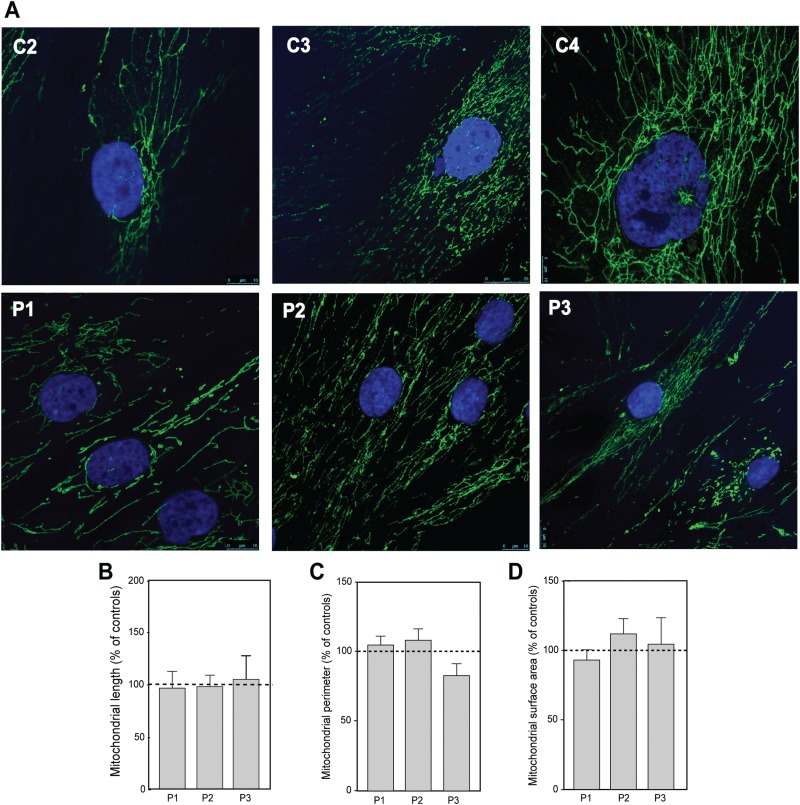
Morphology of mitochondria in CMT2AMFN2 patient fibroblasts. (A) Representative confocal microscopy images of the mitochondrial network, as visualized by anti-TOM20 (shown here in green); 4′,6-diamidino-2-phenylindole (DAPI)-stained nuclei are in blue. (B) Mitochondrial length, measured by confocal microscopy. (C) Mitochondrial perimeter, measured by EM. (D) Mitochondrial surface area, measured by EM.